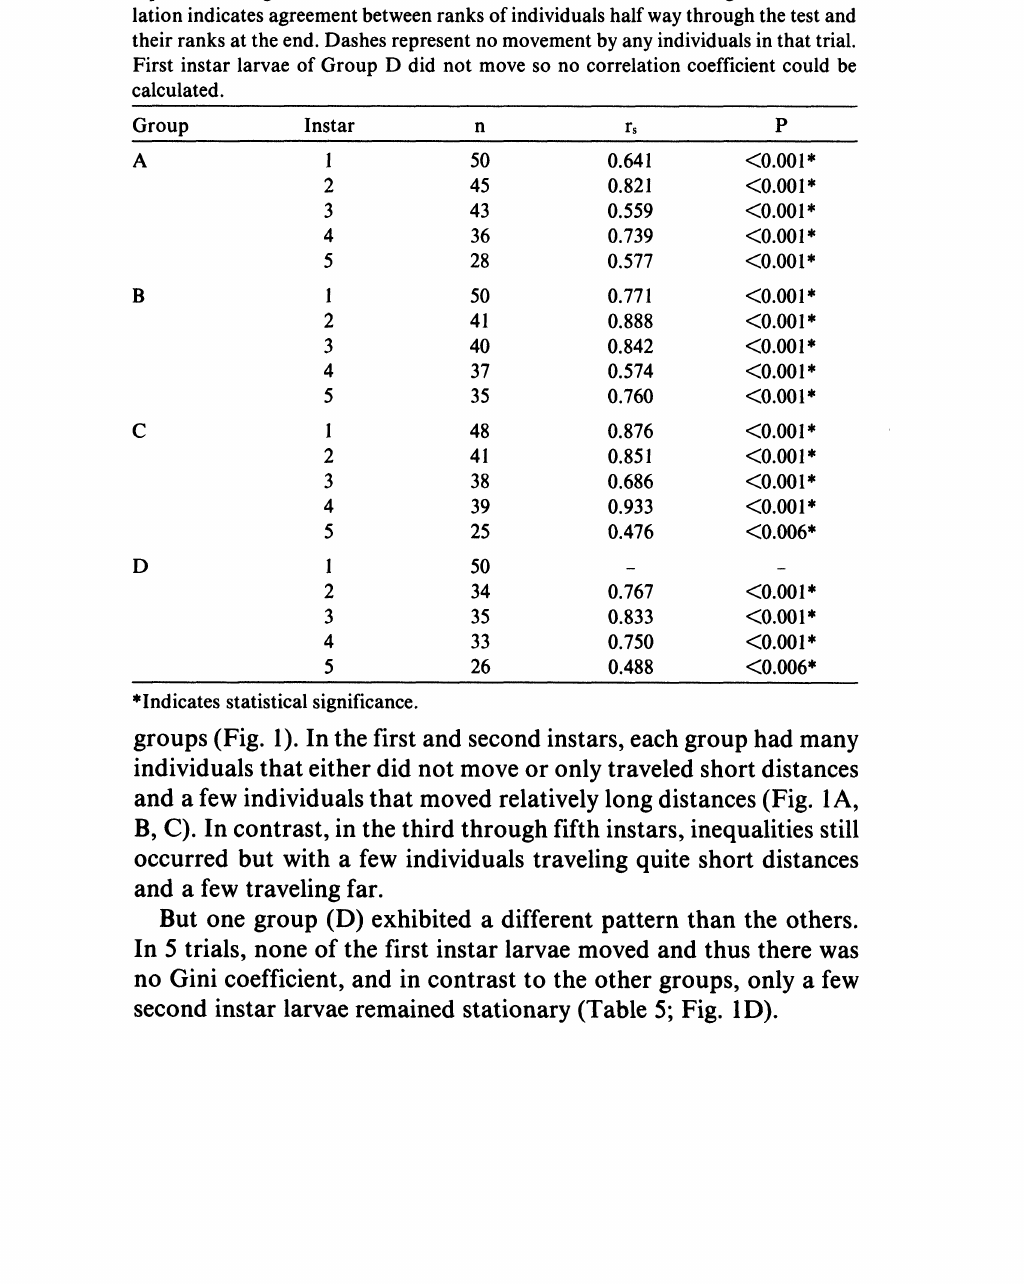
Psyche [Vol. 95 Table 1. Comparison of ranks of individuals in groups after half the test period and at the end of the test, with Spearman rank correlation (rs). Significance level (P) for one tailed test with a 0.05 is shown. In this case, indicates no change in ranks by individuals between the half way point and the end of the test period, and 0 represents no agreement between those ranks. In the cases below, a significant corre- lation indicates agreement between ranks of individuals half way through the test and their ranks at the end. Dashes represent no movement by any individuals in that trial. First instar larvae of Group D did not move so no correlation coefficient could be